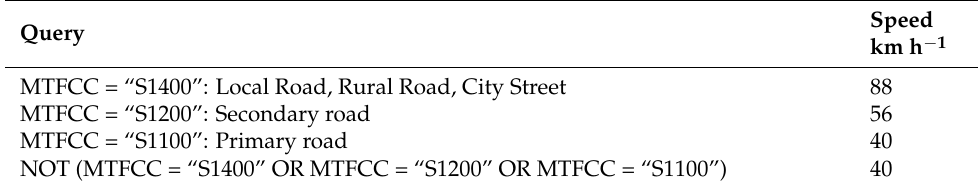
Table 6. Queries used to allocate the average speed to each road segment and its derived raster cells, considering the Master Address File (MAF) TIGER \ Line Feature Class Code (MTFCC) 1